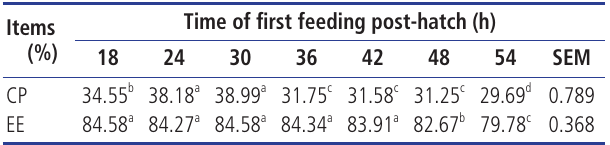
Table 3. Effects of first feeding time on apparent metabolic rate of feed in broilers Time of first feeding post-hatch (h) Items (%)